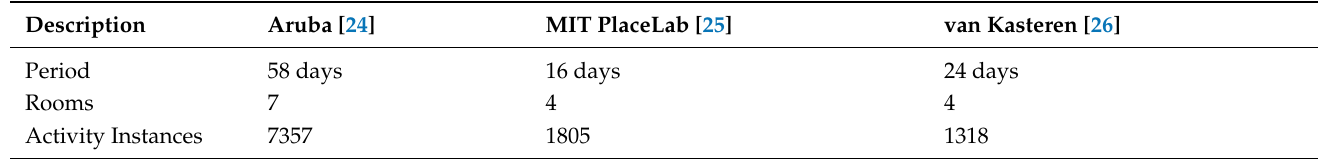
Table 2. Overview of the datasets used in this